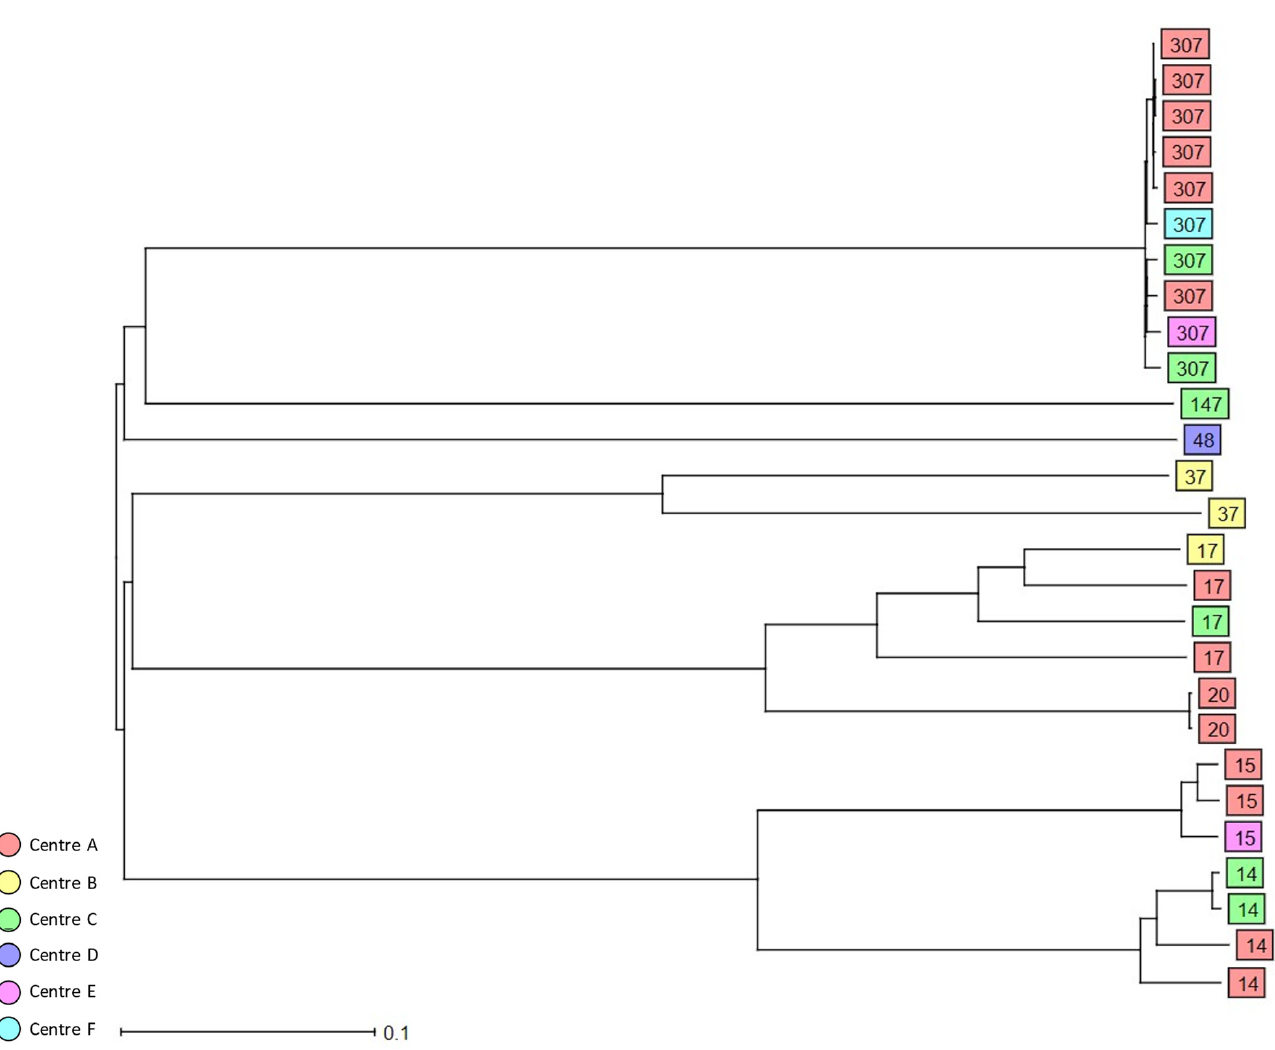
Figure 2. Dendrogram generated using Ridom SeqSphere+ for the HiR 3GCR/CR colonising K. pneumoniae complex isolates ( n = 27) coloured by study centre and identified by ST type, ignoring missing values. Each box represents one isolate from an individual patient according to sequence analysis of 2358 cgMLST target genes.